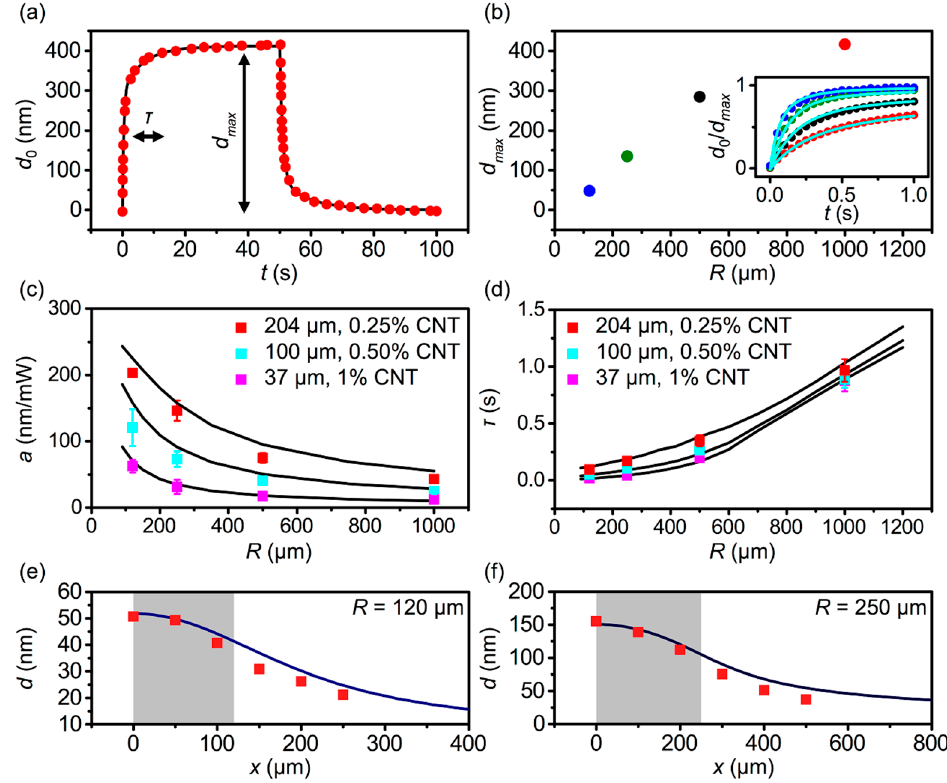
Figure 2. Characterization of photoactuation of PDMS–CNT films, based upon a combined experimental and computational method. ( a ) Typical trajectory of a h = 204 µ m PDMS–CNT composite film, under an illumination intensity I 0 = 0.45 W/cm 2 with R = 1 mm. At a time t = 50 s, after the onset of illumination, the deformation is denoted by d max , with a characteristic rise time τ . ( b ) d max obtained from the same film under a variety of R ranging from 120 µ m (blue), 250 µ m (green), 500 µ m (black), to 1 mm (red). The inset shows d 0 / d max trajectories for these experiments. ( c ) Actuation efficiency ( a = d max / P , where P is the incident optical power) and ( d ) τ vs. R . Profiles of d vs. position x of h = 204 µ m PDMS–CNT with ( e ) R = 120 µ m and ( f ) R = 250 µ m. Grey regions represent the illuminated areas. In all panels, the dots represent results from experiments and solid lines indicate results from the finite element analysis (FEA).